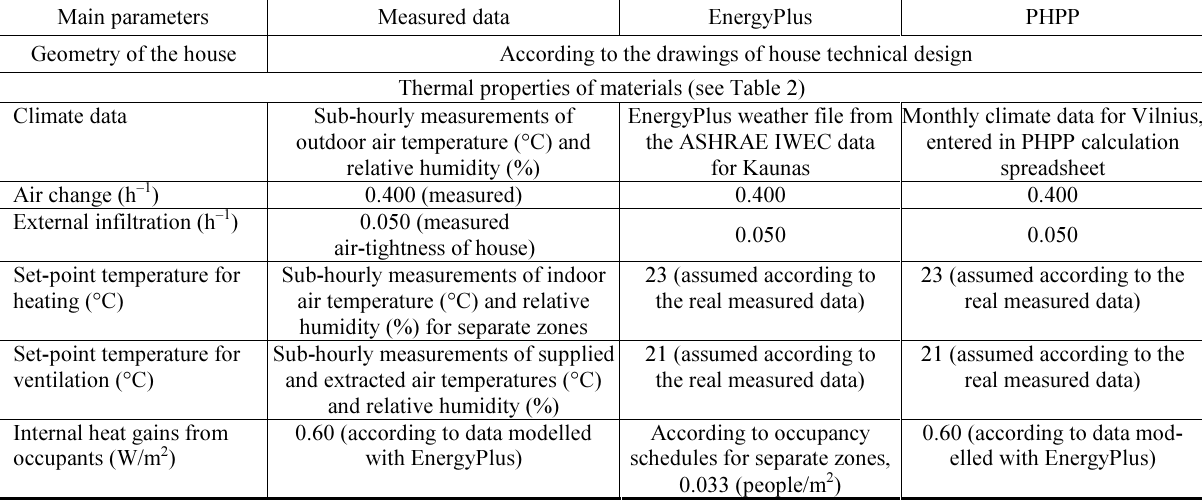
Table 3. The input data for simulation and